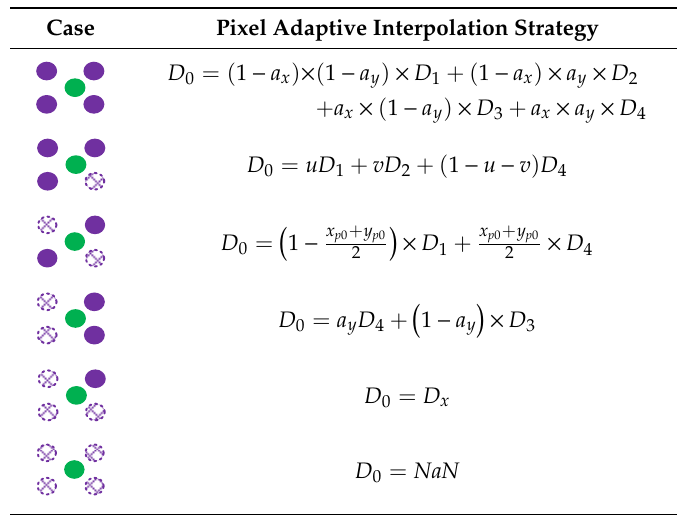
Green points represent the projection of the corrected pixels on the raw image. Purple points are the surrounding pixels of the green ones, in which the solid purples mean the real distance pixel while the hollow ones represent the holes. D 0 , D 1 , D 2 , D 3 and D 4 denote the pixels to be interpolated and its lower-left pixel, top-left pixel, lower-right pixel and top-right pixel, respectively. ( x p0 , y p0 ), ( x p1 , y p1 ), ( x p2 , y p2 ), ( x p3 , y p3 ) and ( x p4 , y p4 ) are the coordinates of the pixels to be interpolated and its lower-left pixel, top-left pixel, lower-right pixel and top-right pixel, respectively. α x = x p 0 − x p 1 , α y = y p 0 − y p 1 and ( u , v ) are the coordinates of the pixels to be interpolated under a barycentric coordinate system. 3.2. Grayscale Image Calibration A grayscale image is acquired by TOF chip when PMD solid-state Array Lidar works in the passive mode. The acquisition process is consistent with the intensity image obtained by traditional complementary metal oxide semiconductor (CMOS) chip, which can be used to characterize the intensity of ambient light. In general, the grayscale image is vulnerable to DSNU and PRNU, where DSNU represents the differences of gray values between pixels captured under the dark condition and PRNU represents the differences of gray values between pixels captured under the common condition, respectively. The most commonly used approach to correct the influence of DSNU and PRNU has a standardized process, which can be found in european machine vision association (EMVA) standard 1288 [50]. In this approach, one dark image and one bright image are captured under the same exposure condition. DSNU and PRNU are then calculated from the images. However, there exist some limitations of the approach. For instance, the images are captured under a specific condition, leading to bad applicability. The ambient light is set artificially, which introduces extra error. Based on this approach, an integration time simulating based method was proposed in this paper. The main contributions of the method mainly include: (I) Instead of setting the ambient light artificially, the levels of ambient light were simulated by setting the integration times and (II) the non-uniform of the exposure was eliminated by calculating the mean value of multiple ambient light levels. The process of the method is given as follows. (1). Set the integration time to 0 μ s to simulate the dark condition. Collect N = 100 frames of grayscale images and calculate the mean value.